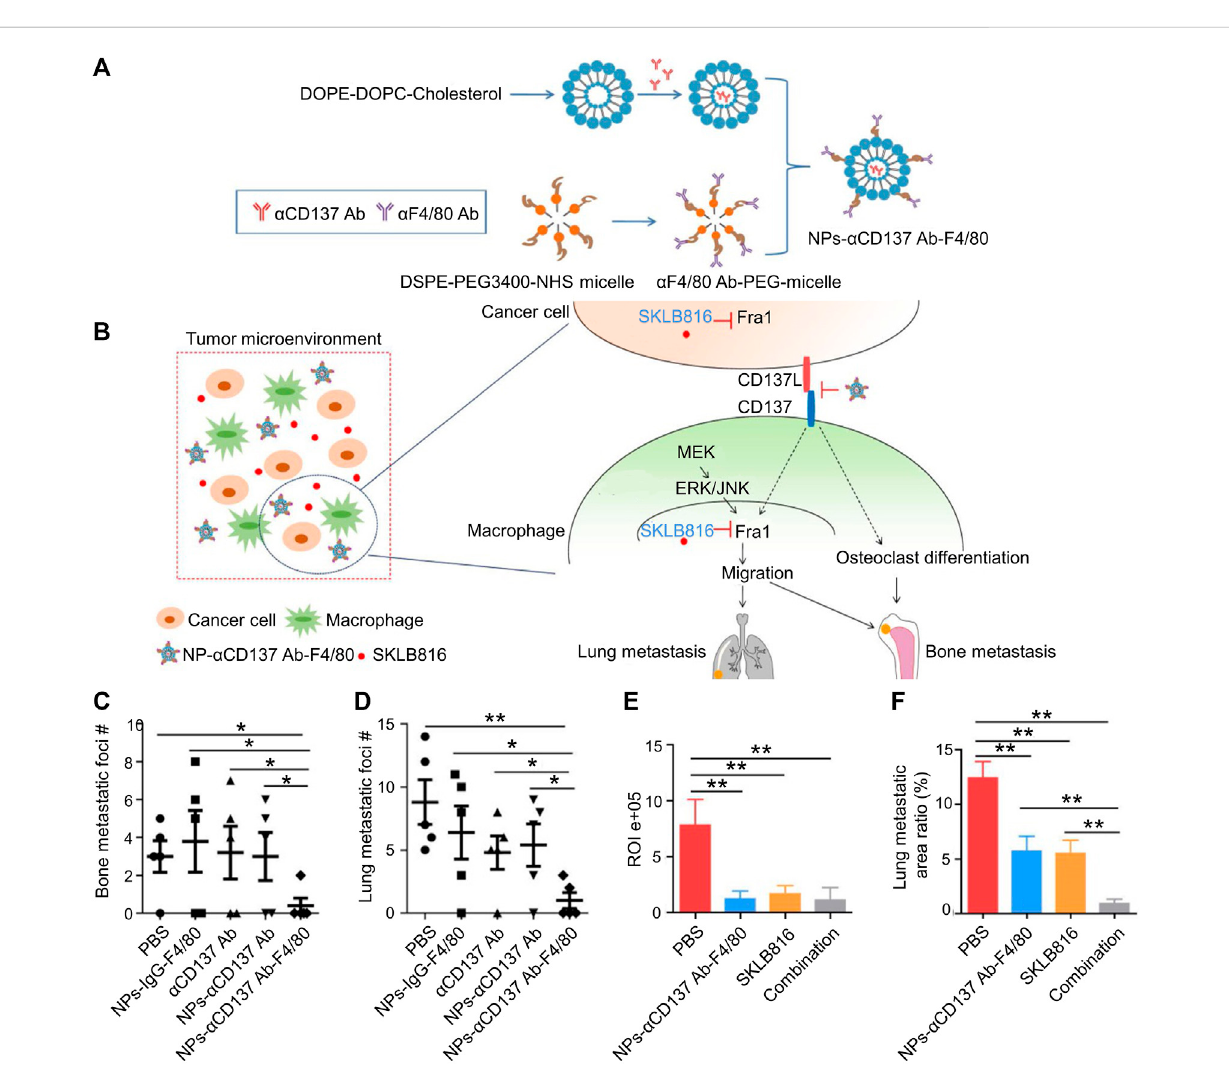
FIGURE 3 Dual-targettherapy againstCD137 and Fra1 for BC. (A) Schematic illustration for thepreparationofNPs- α CD137Ab-F4/80. (B) Schematicsummary of treatment model: NPs-CD137 Ab-F4/80 suppress osteoclasts and lessen osteoclast migration by blocking CD137 signaling in macrophages. (C – D) StatisticalresultsofthenumberofmetastasesinlungsandbonesinNPs- α CD137Ab-F4/80treatment( n =5mice). (E) StatisticalresultsofnormalizedBLI signals ( n = 4 mice). (F) Lung metastasis area ratio results ( n = 4 mice), Data are represented as mean ± SD (* p < 0.05, ** p < 0.01). Reproduced with permission (Jiang et al., 2019) Copyright © 2019,